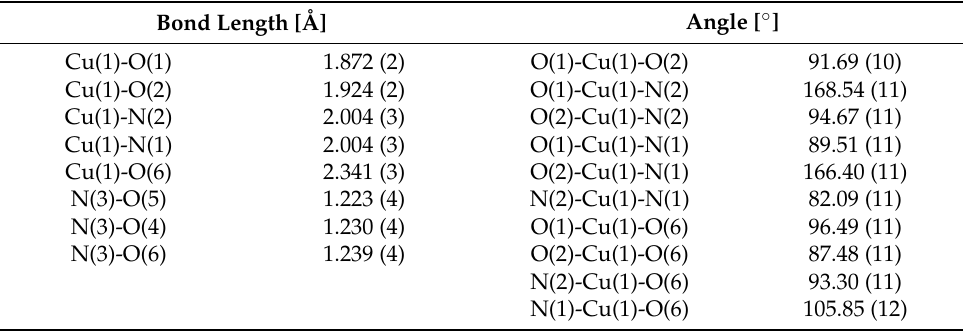
Figure 4. Molecular structure of [Cu(phen)(L)(NO 3 )] as determined by a single crystal X-ray analysis. The carbon atoms are depicted using a dark-grey color, while the H-atoms are depicted in a light-grey color. The color coding of the atoms is as follows: hydrogen atom − light gray, carbon atom − dark gray, nitrogen atom − blue, oxygen atom − red, copper atom − turquoise.